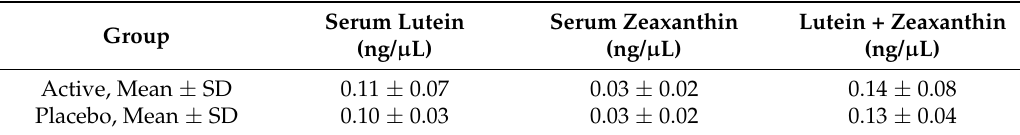
Table 3. Baseline serum levels by supplement